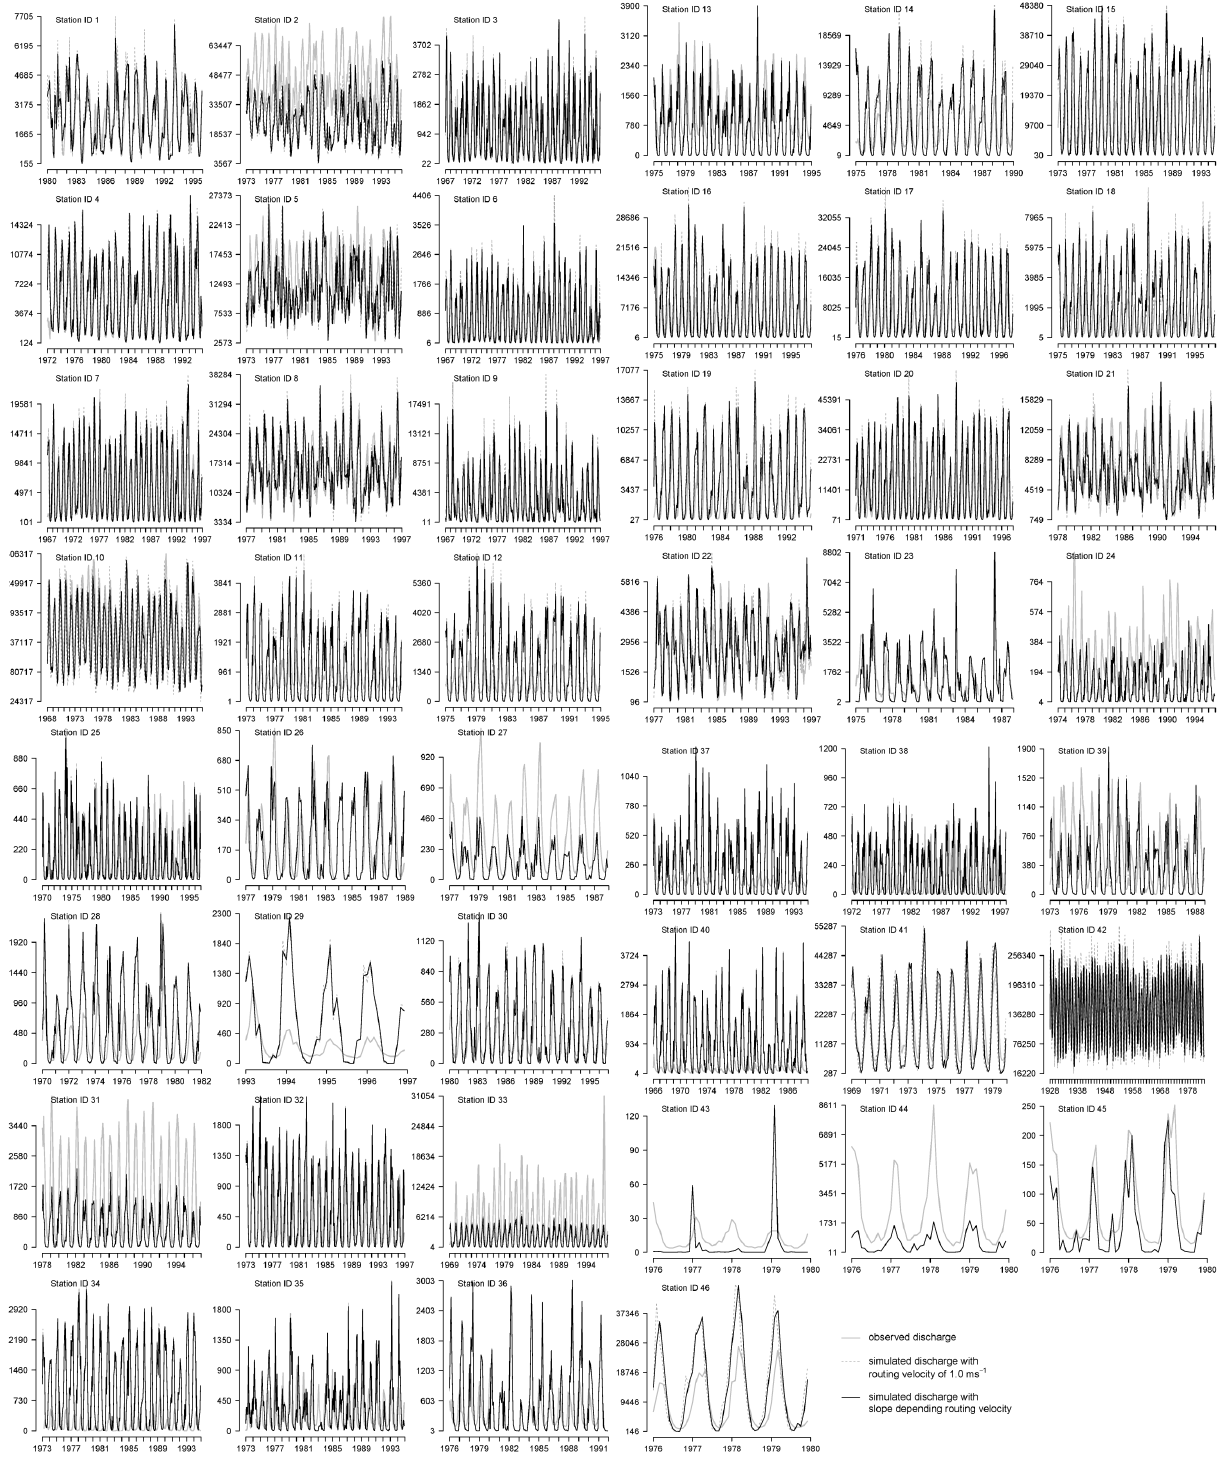
Figure 3. Observed and simulated discharge [m 3 s −1 ] for all 44 sites. Observed 826 discharge as solid grey line, simulated discharge with routing velocity of 1.0 ms -1 as 827 dashed grey line, and simulated discharge with slope depending routing velocity as 828 solid black line. 829 830